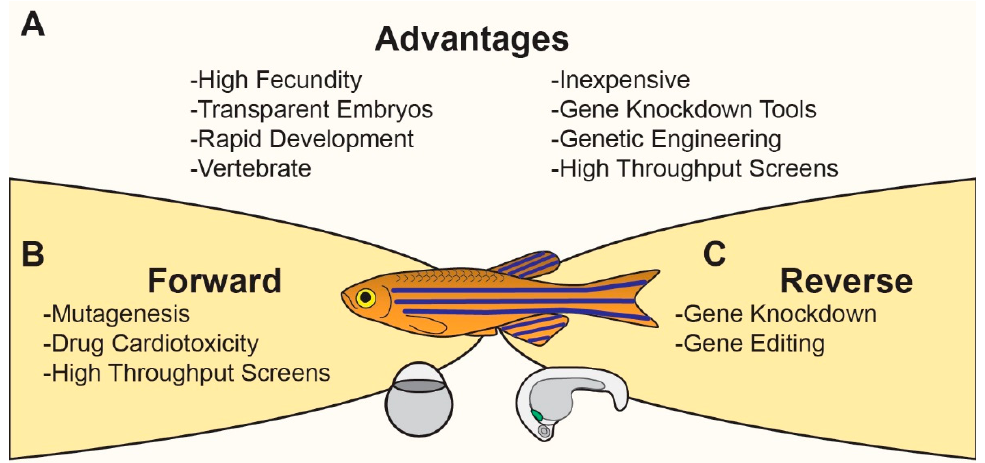
Figure 1. Zebrafish Model System. Schematic illustrating ( A ) the advantages of zebrafish as a model system, ( B ) forward genetic and ( C ) reverse genetic approaches to studying heart development and disease in zebrafish.